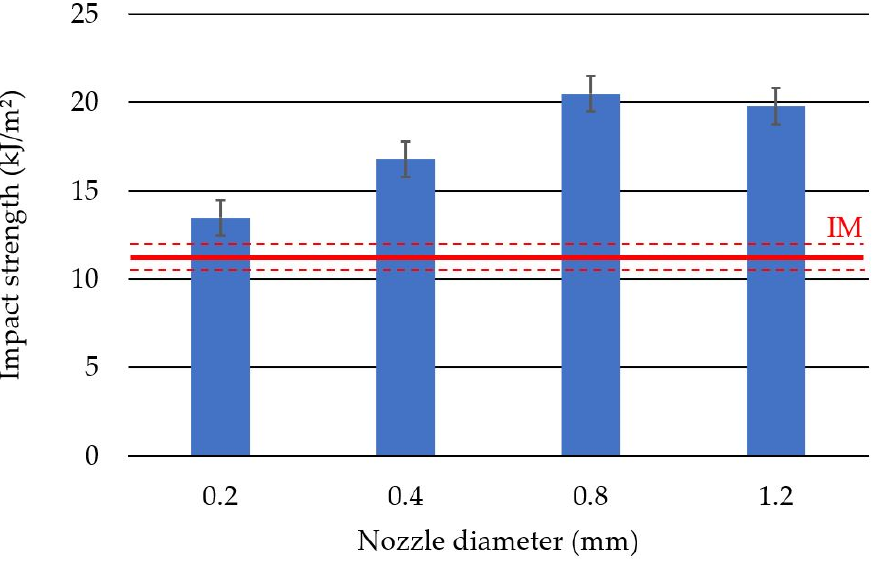
Figure 11. Average impact strength values with standard deviation for specimens produced with different nozzle diameters. IM—average value obtained for injected specimens. different nozzle diameters. IM—average value obtained for injected